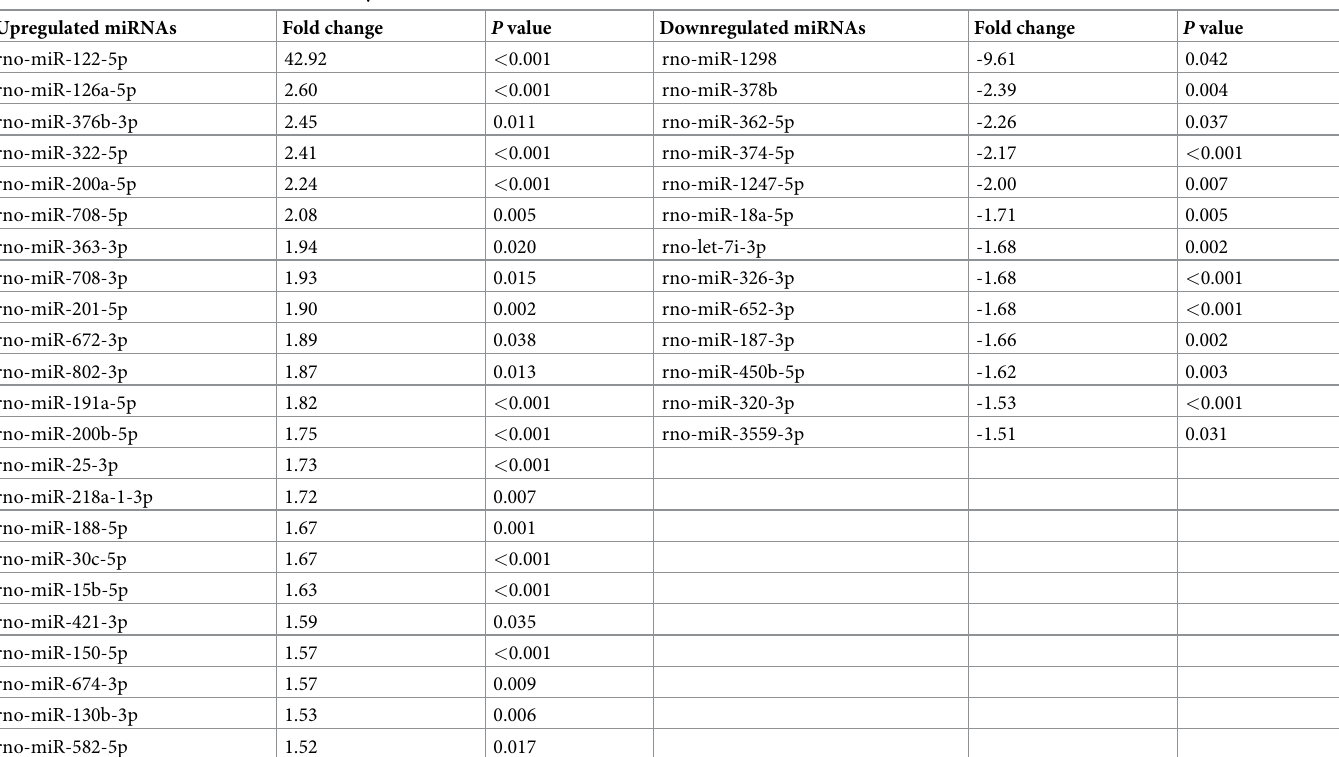
Table 2. List of DE mature miRNAs in kidneys of CI-AKI